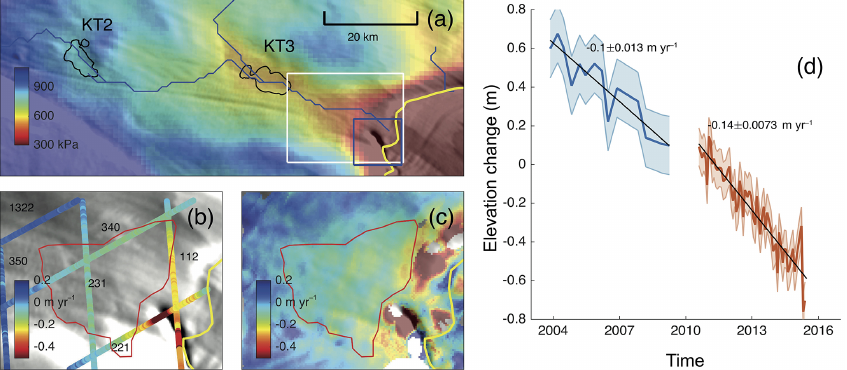
Figure 6. Elevation changes near the KIS grounding line. (a) Hydraulic potential (colored shading) and flow lines (blue lines) from KT2 to the grounding line (yellow line). The white rectangle indicates the area displayed in (b) and (c) . The blue rectangle indicates the area shown in Fig. 7. (b) Elevation change rate estimated from ICESat repeat-track analysis. (c) Elevation change rate estimated from CryoSat-2 DEM differencing (2014–2011). (d) Temporal elevation changes of ICESat and CryoSat-2 measurements in the “estuary” area, denoted by the red polygon in (b) and (c) . The bias of CryoSat-2 elevations was removed, including the instrument bias (0.67m) and the effect of radar penetration into the snow pack (1.03m) which is estimated along an adjacent ICESat